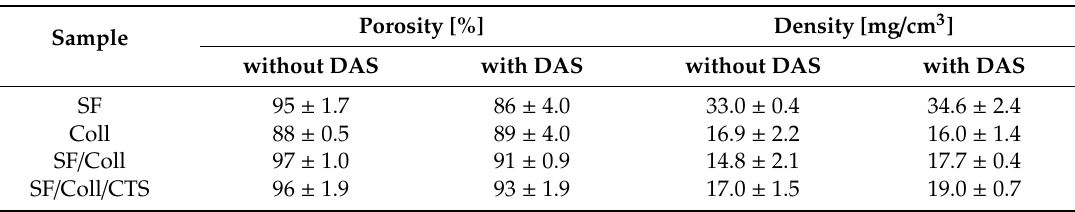
Table 1. Porosity and density of the sca ff